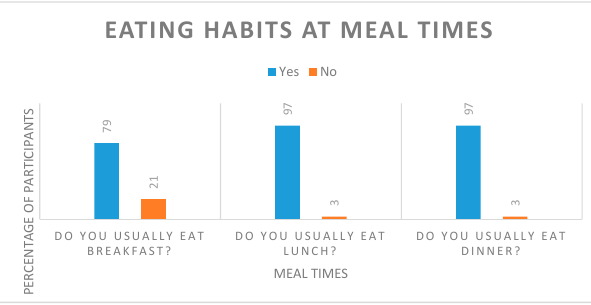
Figure 3. Eating habits at standard meal times reported by study participants.